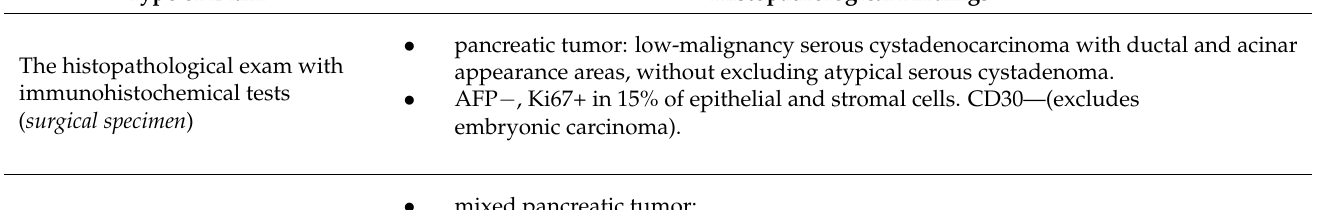
Table 3. Synopsis of histological